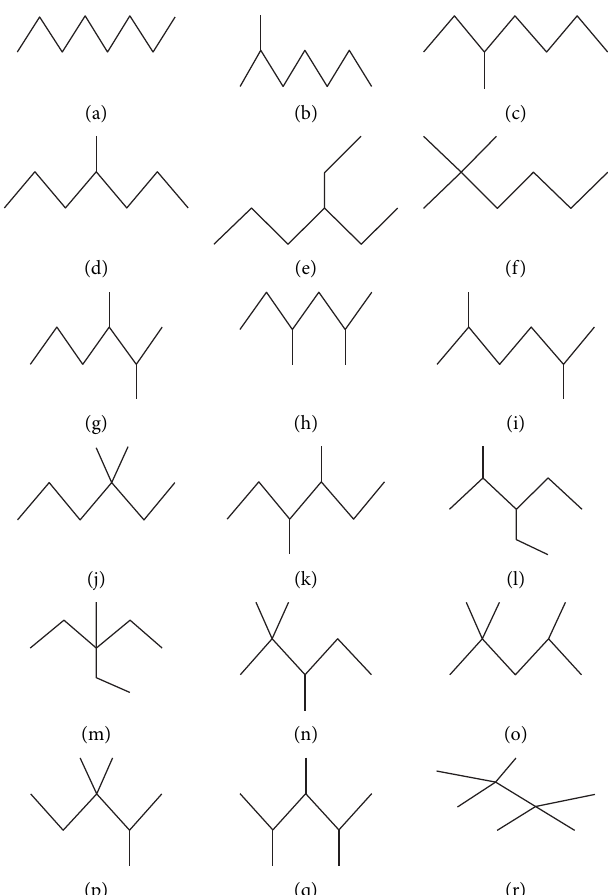
Figure 1: (a) n -Octane, (b) 2-methylheptane, (c) 3-methylheptane, (d) 4-methylheptane, (e) 3-ethylhexane, (f) 2,2-dimethylhexane, (g) 2,3- dimethylhexane, (h) 2,4-dimethylhexane, (i) 2,5-dimethylhexane, (j) 3,3-dimethylhexane, (k) 3,4-dimethylhexane, (l) 3-ethyl-2-methyl- pentane, (m) 3-ethyl-3-methylpentane, (n) 2,2,3-trimethylpentane, (o) 2,2,4-trimethylpentane, (p) 2,3,3-trimethylpentane, (q) 2,3,4-tri- methylpentane, and (r) 2,2,3,3-trimethylbutane. Table 1: Experimental values of S , AF, HVAP, and DHVAP and the corresponding values of the GH index, HG index, NGH index, and NHG index of octane isomers.